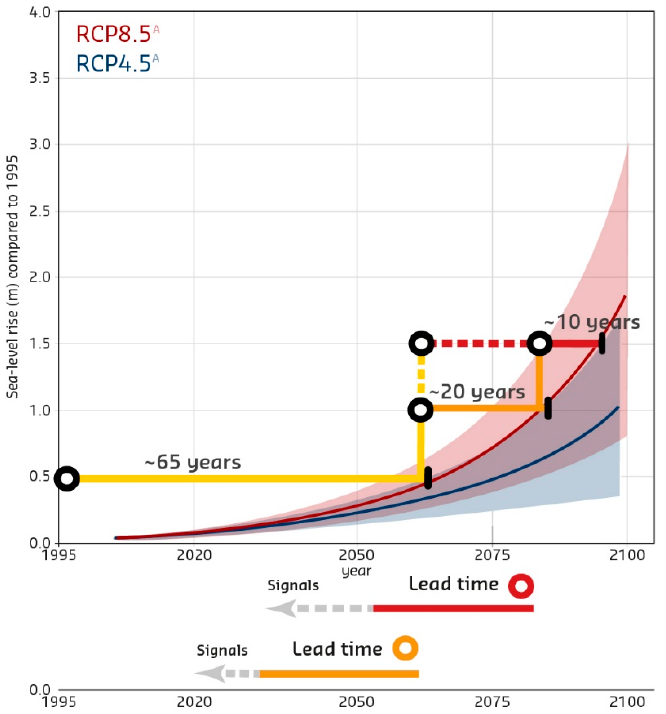
Figure 4. The effect of accelerated SLR on the lifetime of investments. In the present situation, a design for 50 cm holds 65 years. The potential acceleration later this century reduces the lifetime of a 50 cm design to about 10 years (Reprinted with permission from Haasnoot et al. 2020 [10]).